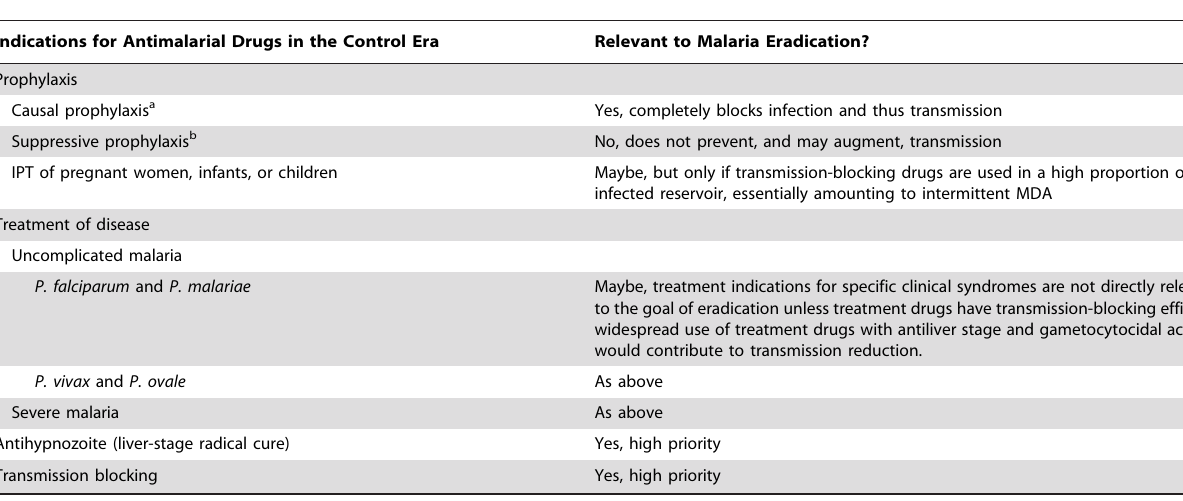
Table 1. Indications for antimalarial drugs in the present control era and their relevance in the eradication era.